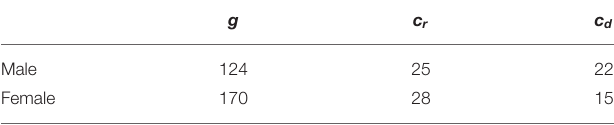
TABLE 1 | Cortisol response curve parameters.